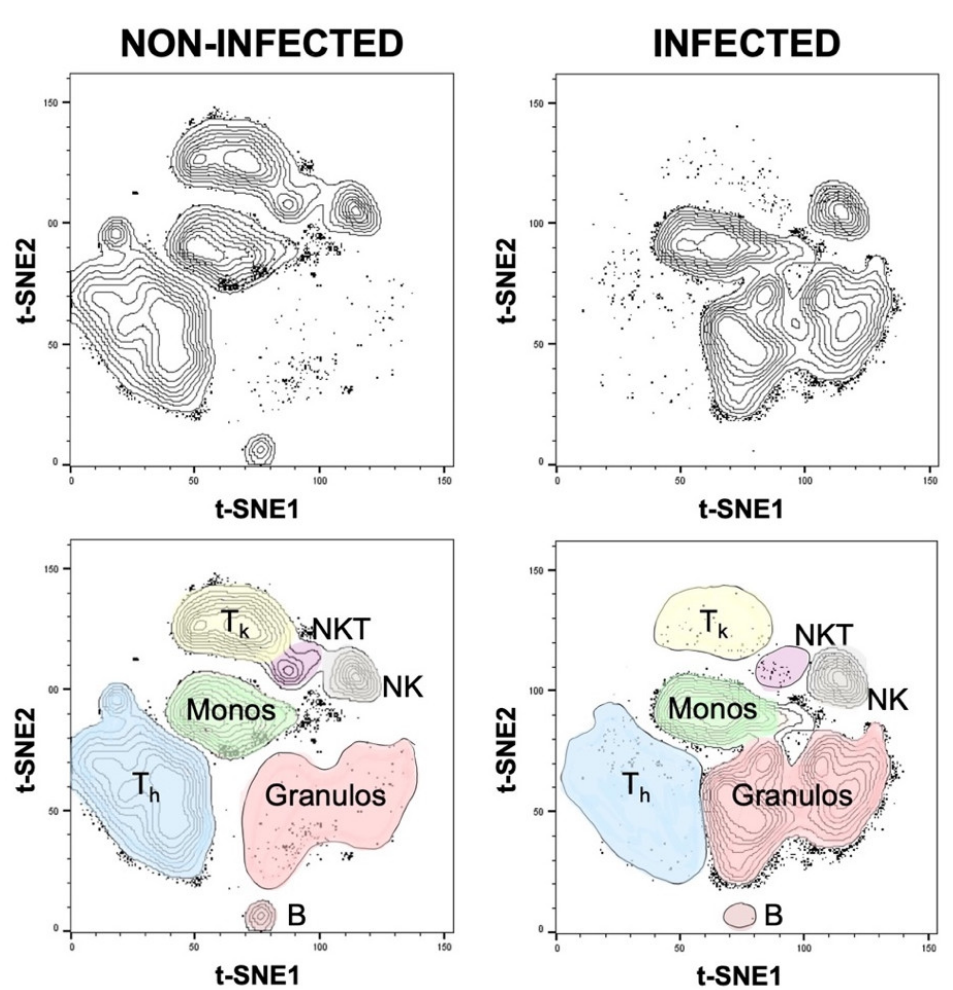
Figure 6. Proportion of granulocyte subpopulations in relation to total granulocytes. Percentage of ( A ) neutrophils, ( B ) eosinophils and ( C ) basophils for both non-infected and infected samples are shown. Only basophils showed a significant difference between non-infected and infected samples. * p < 0.05, ns: non-significant.